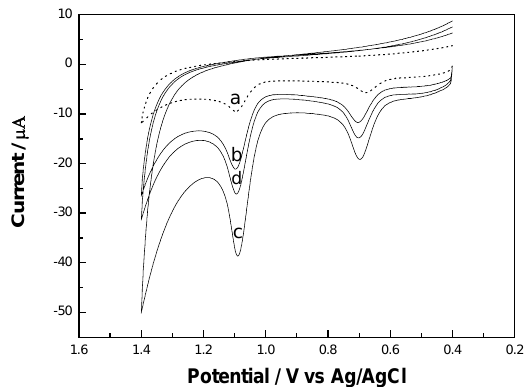
Figure 6. Cyclic voltammograms of 3.5 × 10 -6 M meloxicam at the cysteic acid/GCEs prepared in modified solution with different sweep circles. a, the bare glassy carbon electrode; b, 5 circles; c, 10 circles; d, 15 circles. Scan rate: 100 mV·s -1 ; electrolyte: B-R buffer solution (0.04 M, pH 1.86). 3.3. Electrochemical Reaction Mechanism of Meloxicam at the Cysteic Acid Modified